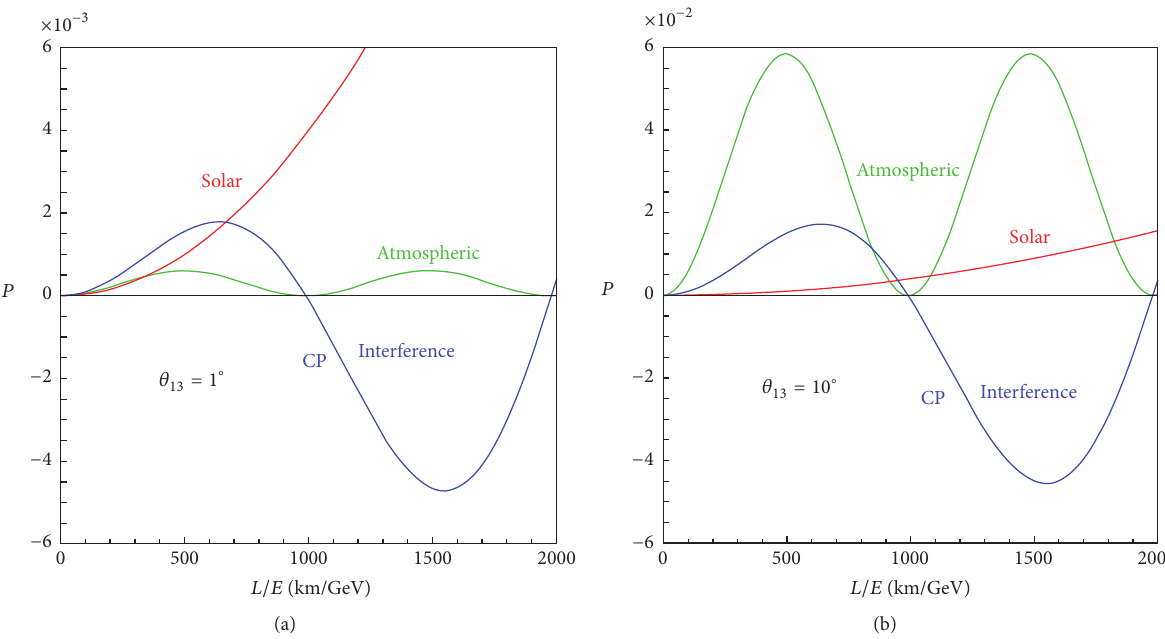
Figure 2: Plots showing, for two different values of the neutrino mixing angle 𝜃 13 = 1 ∘ (a) and 𝜃 13 = 10 ∘ (b), the three terms in the expression for the ] 𝜇 → ] 𝑒 oscillation probability as a function of the ratio between the accelerator-to-detector distance 𝐿 (the baseline) and the neutrino energy 𝐸 [19]. The CP violating term is calculated without the factor cos (𝛿 CP −Δ 31 𝐿/2) ; that is, what is shown is the maximum value this term could take on.